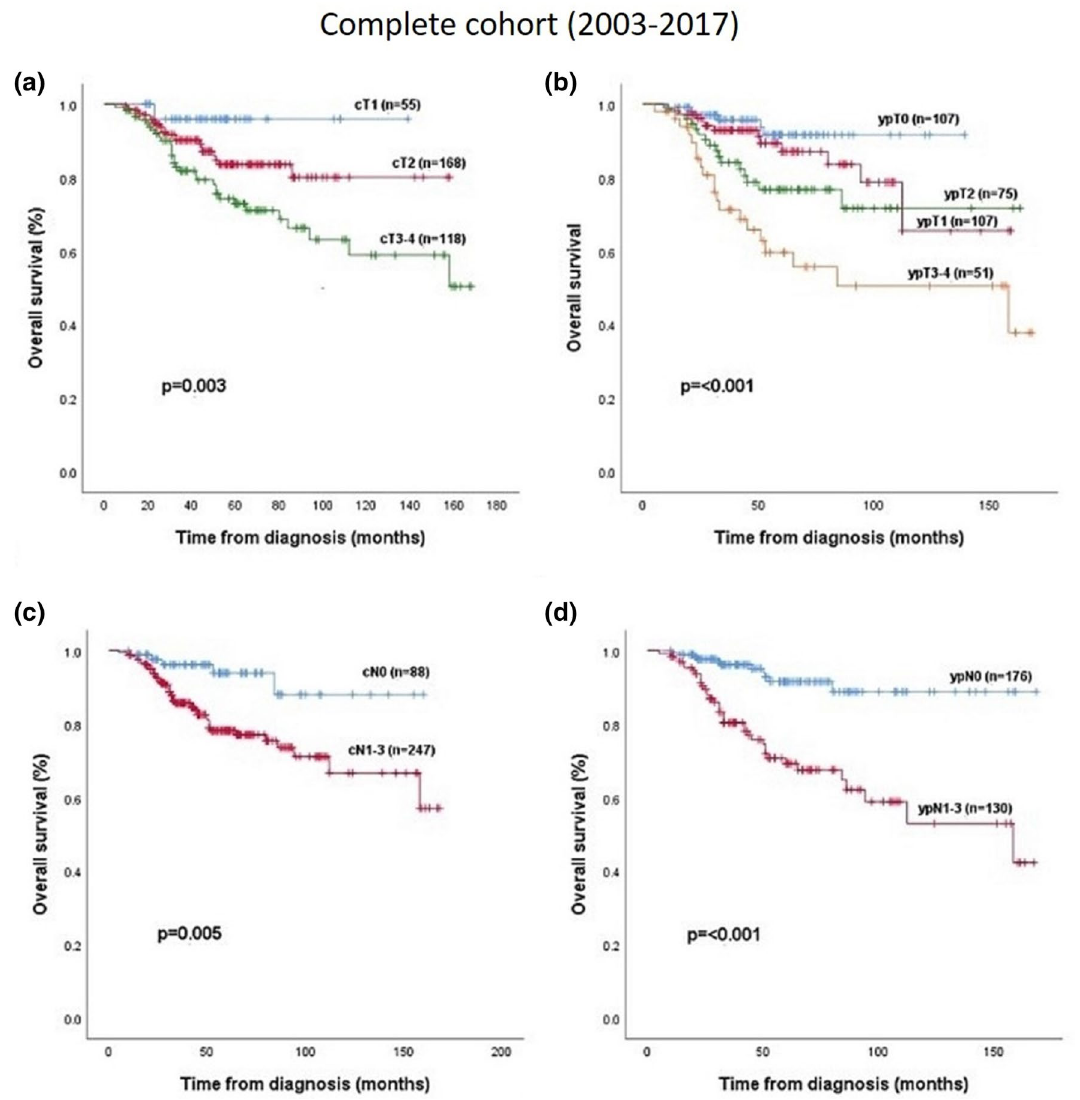
Figure 1. Overall survival in relation to ( a ) cT-stadium, ( b ) ypT-stadium, ( c ) cN-stadium and ( d ) ypN-stadium in the whole cohort